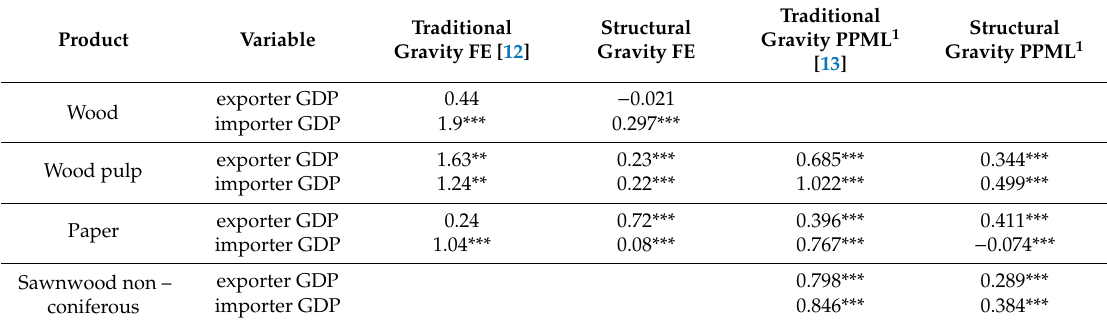
Table 3. Comparison of GDP e ff ects from structural (own estimations) and traditional gravity (results from